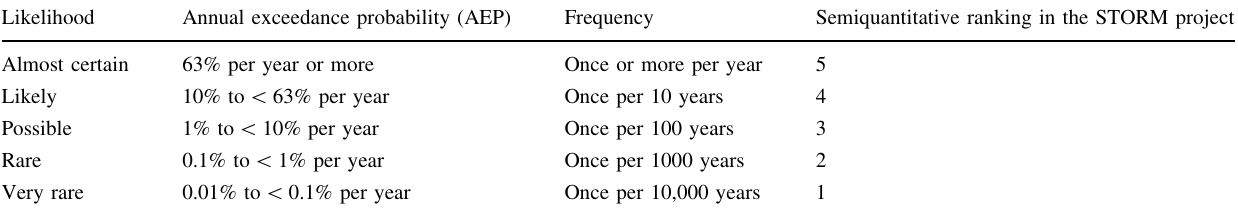
Table 2 Natural hazard likelihood level. Source adapted from AEMC (2015) Likelihood